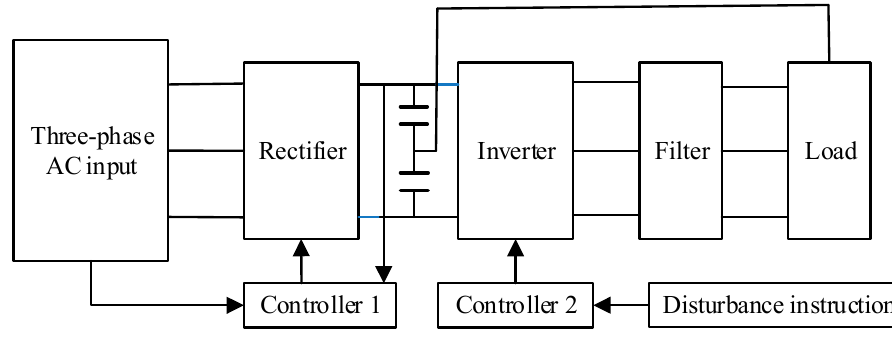
Figure 1. Structure diagram of the proposed system.